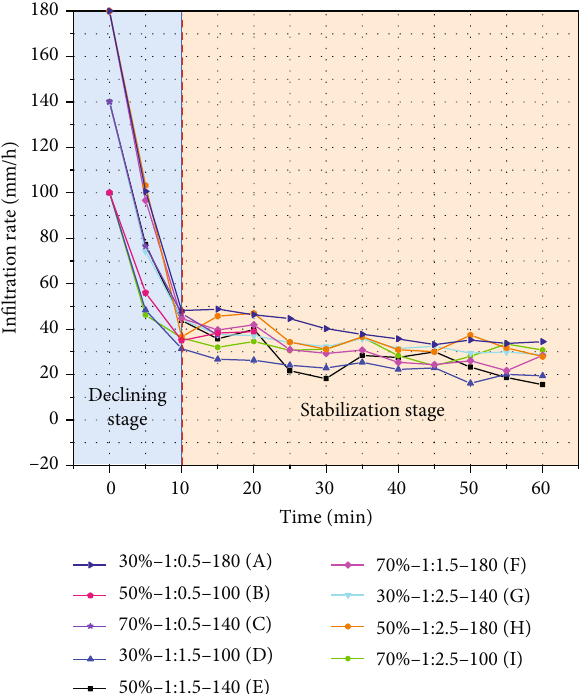
table. Corresponding numbers for the slope ratio and rainfall intensity were calculated